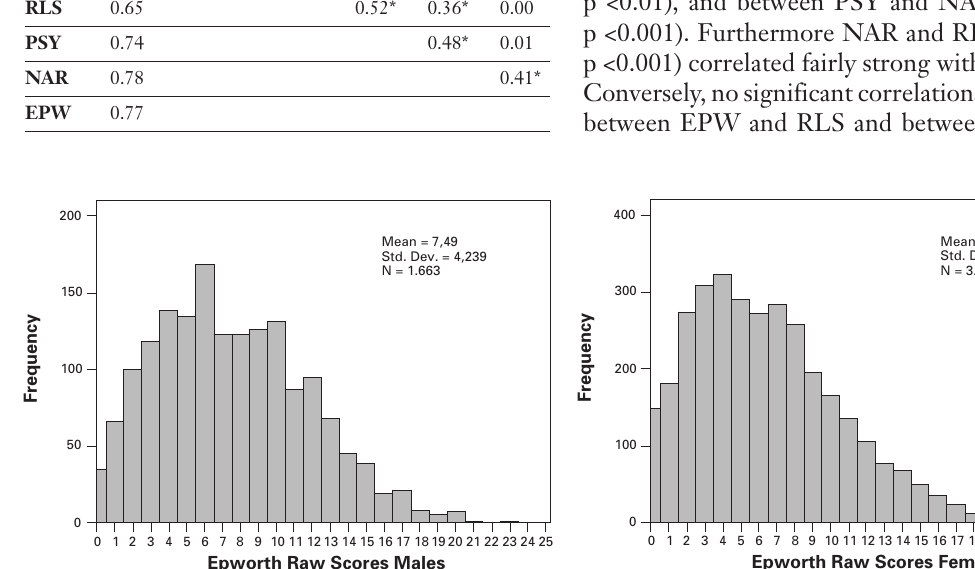
Cronbach’s alpha of scales, Spearmans correlation coeffi- cients for sum scores of symptom clusters in 4901 question- naire respondents (3238 females, 1663 males). * P <0.01. SAS: sleep apnoea syndrome; PSY: psychiatric sleep disorders; RLS: restless legs and periodic limb movement disorder; NAR: narcolepsy; EPW: Epworth Sleepiness